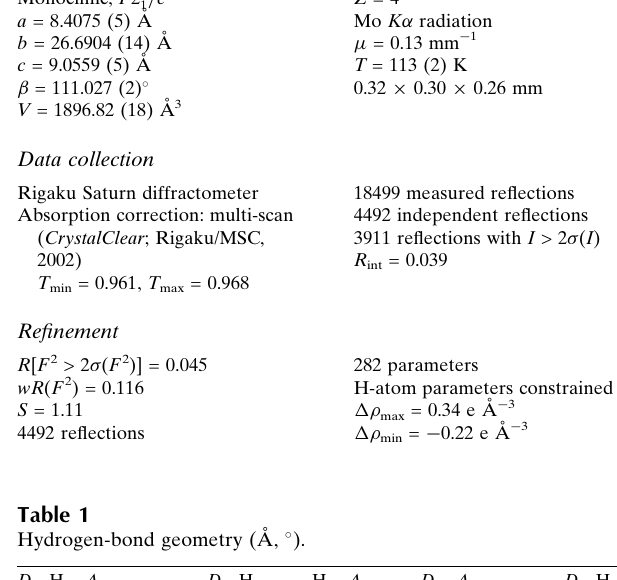
Rigaku Saturn diffractometer Absorption correction: multi-scan ( CrystalClear ; Rigaku/MSC, 2002)